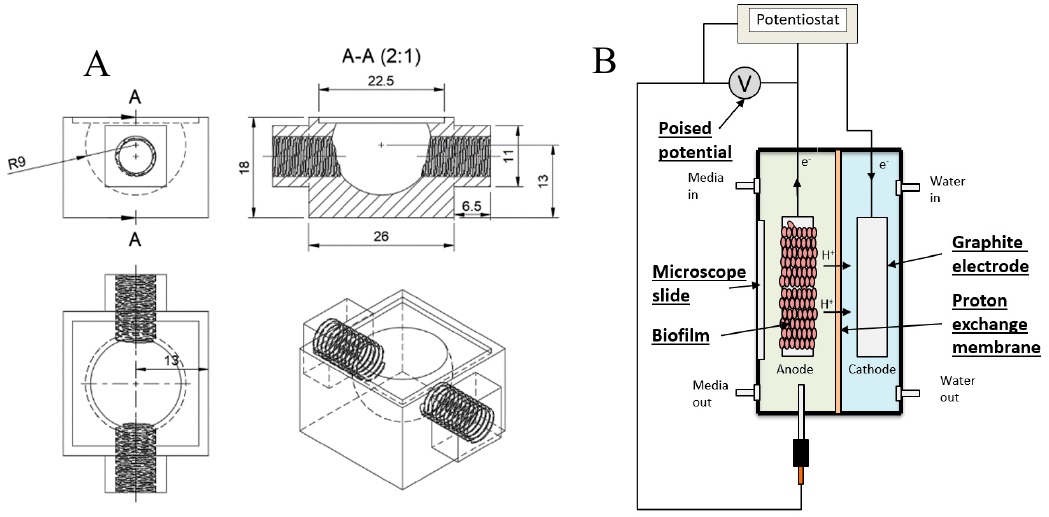
Figure9. Schematicsof( A )the3Dprintedcelland( B